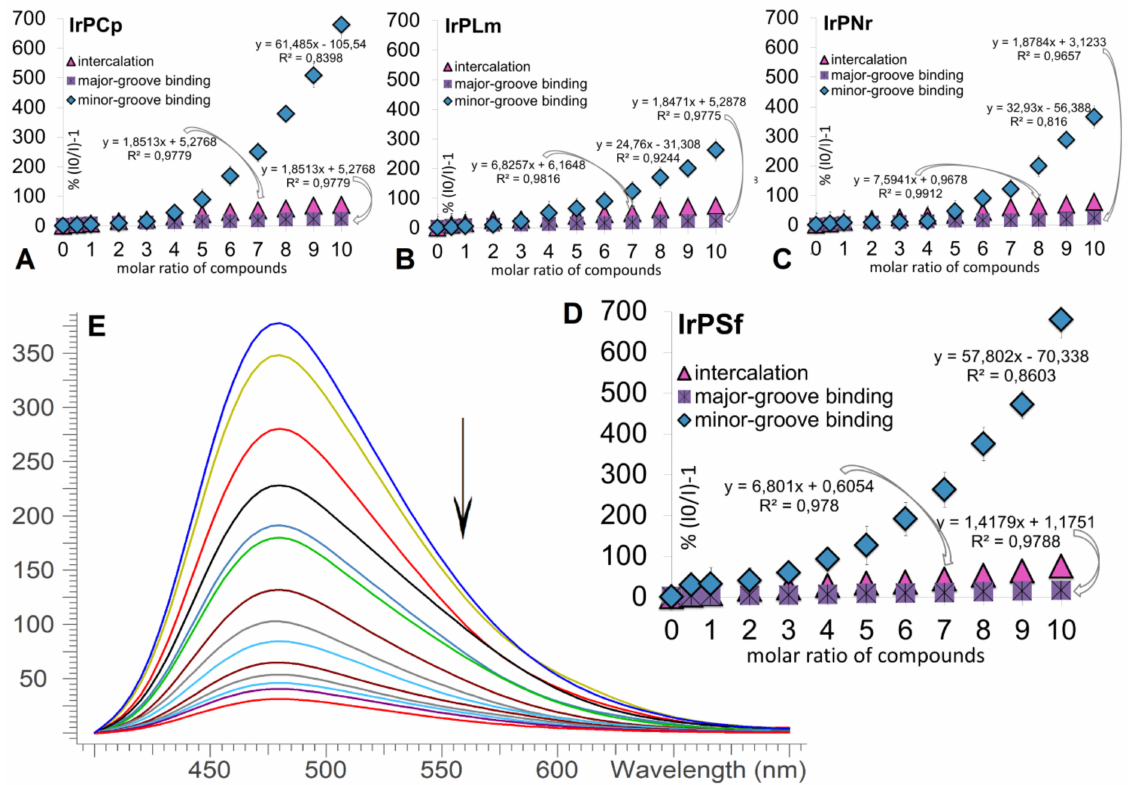
Figure 2. Stern–Volmer plots of the CT DNA-EB (intercalation), CT DNA-DAPI (binding to a minor groove) and CT DNA-MG (binding to a major groove), system quenched by ( A ) IrPCp ; ( B ) IrPLm ; ( C ) IrPNr ; ( D ) IrPSf ; (I 0 and I—intensity of CT DNA-EB or DAPI or MG in the absence and the presence of increasing concentration [mM] of the compounds; ( E ) Fluorescence quenching of DAPI-DNA (C = 5 × 10 − 5 M) by IrPSf (molar ratios 0.5–10) in 50 mM pH 7.4 phosphate buffer (axis: y—fluorescence intensity;